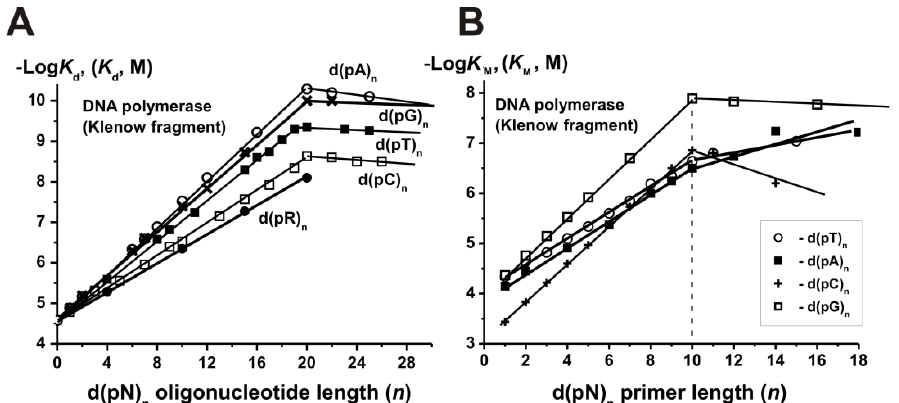
Figure 1. Dependencies of − Log K d characterizing the affinity of ss d(pN) n deoxyribooligonucleotides to template-binding site of DNA polymerase (Klenow fragment, Escherichia coli ) versus their length ( n ) ( A ). All d(pN) n are shown in panel A; d(pR) n oligomers do not contain any bases [19–21]. Dependencies of − Log K m values corresponding to different d(pN) n primers on their length ( n ) in the reaction catalyzing by Klenow fragment of E. coli. ( B ). The K m values in each case were determined using the poly(N) templates complementary to the primers used [23]. Figure 1A shows that the minimal ligands of the DNA polymerase template binding site are ortho phosphate and various dNMPs. With the lengthening of the ss d(pN) n , the affinity gradually increases up to 20 nucleotide units, which are covered by the enzyme globule. In addition, the growth in the affinity of ss d(pN) n for the enzyme increases with an increase in the hydrophobicity of their bases: C < T < G < A. From the slopes of the curves for oligonucleotides, one can calculate the coefficient reflecting the increase in affinity with lengthening of each of the d(pN) n by one nucleotide